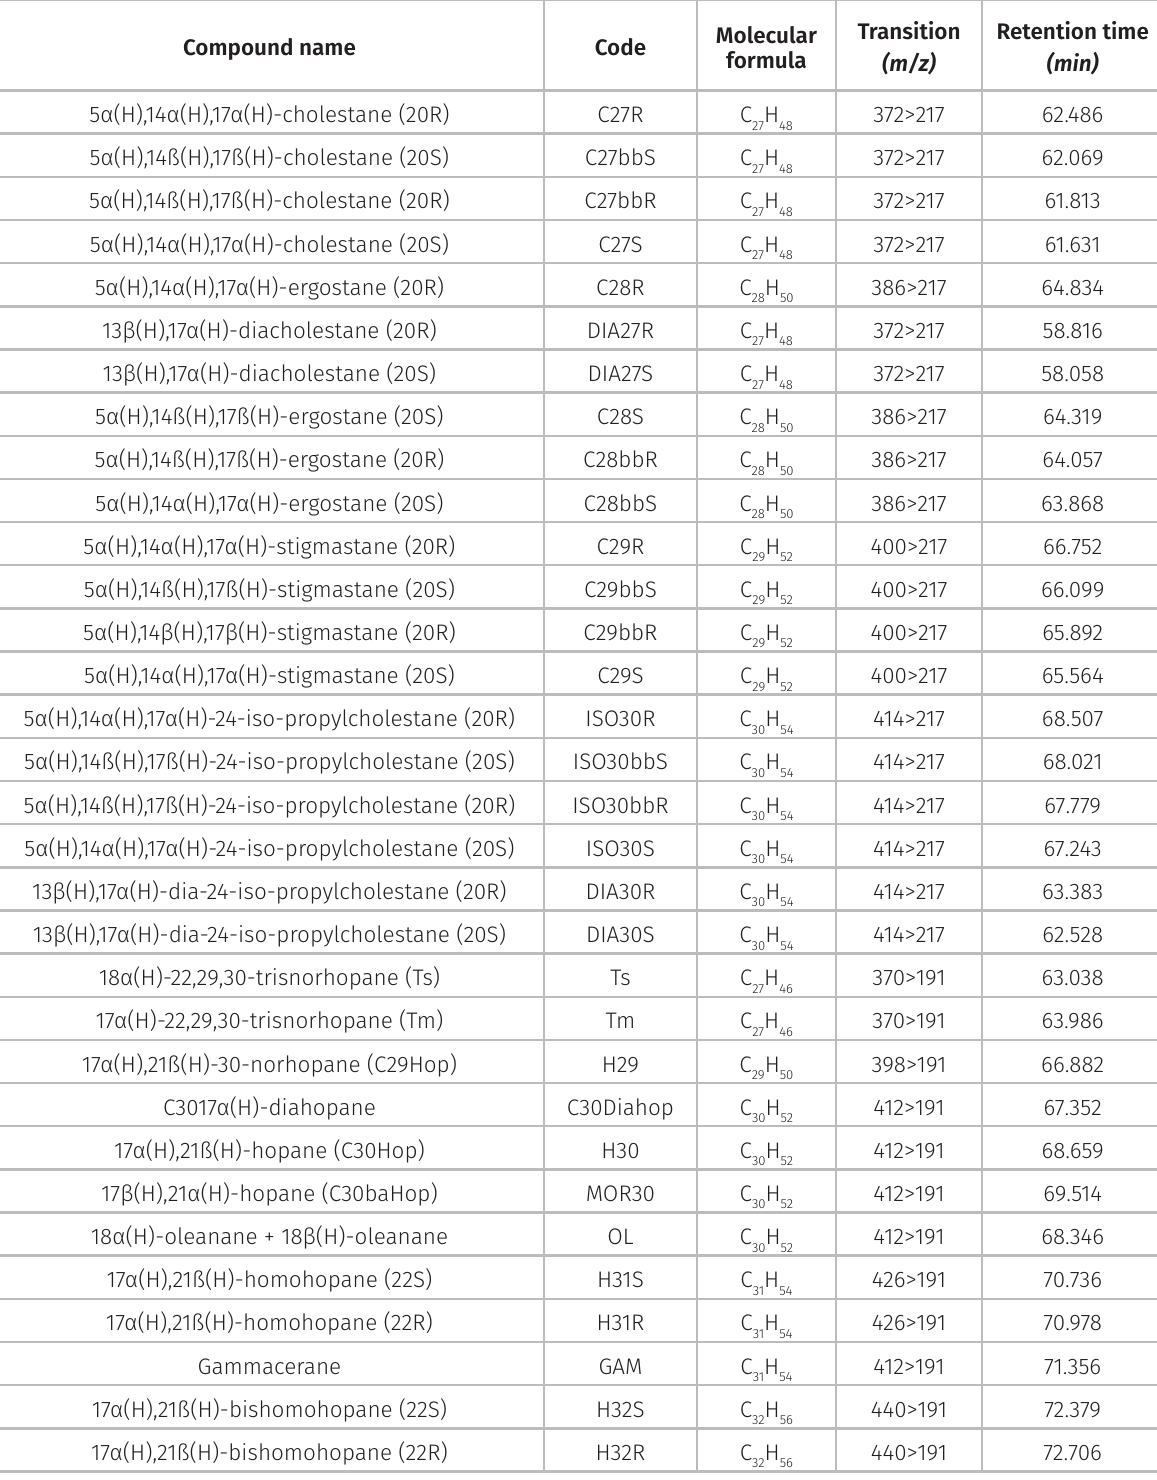
Table II. Transitions (precursor ions and product ions) used for the investigation and identification of steranes and hopanes in MRM